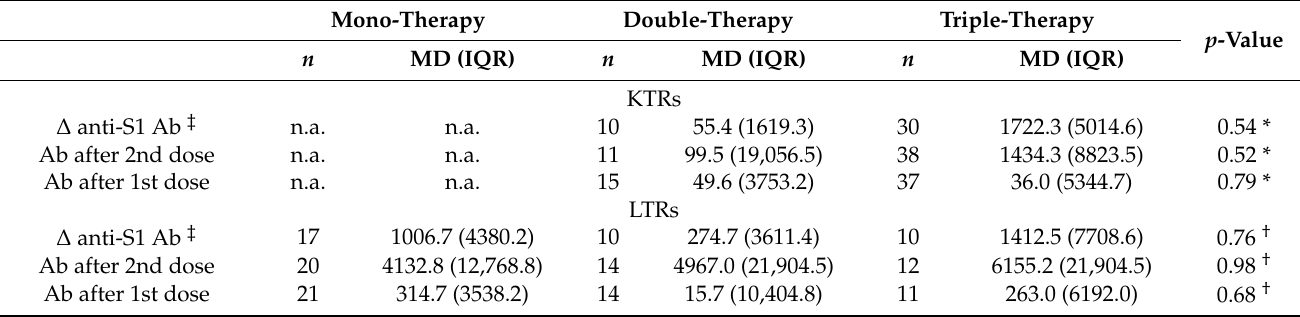
Table A1. Correlation of SARS-CoV-2 spike protein Ab concentration (AU/mL) after BNT162b2 vaccination to maintenance immunosuppression in KTRs and